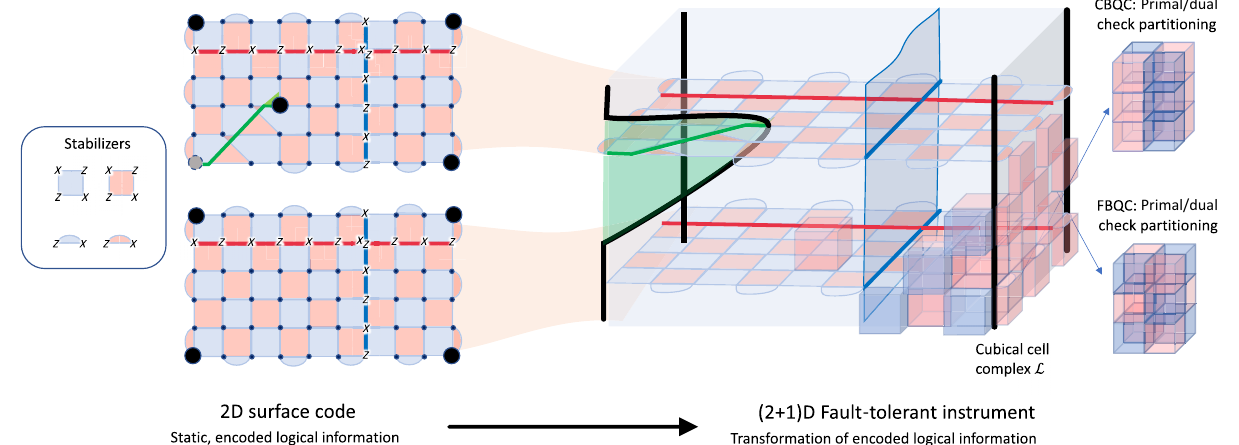
FIG. 5. Left: the surface code consists of stabilizer check operators supported on primal (blue) and dual (red) plaquettes. Stabilizers on the primal (dual) boundary consist of truncated primal (dual) stabilizer operators. Logical Pauli operators for the surface code consist of operators supported on nontrivial cycles of the underlying surface, or between distinct boundaries. Right: representation of a topological instrument network; if implemented in CBQC, each slice of the network describes stabilizer measurement instructions to perform on a plane of qubits. If implemented in FBQC, the network globally describes what fusions and measurements one should perform between and on resource